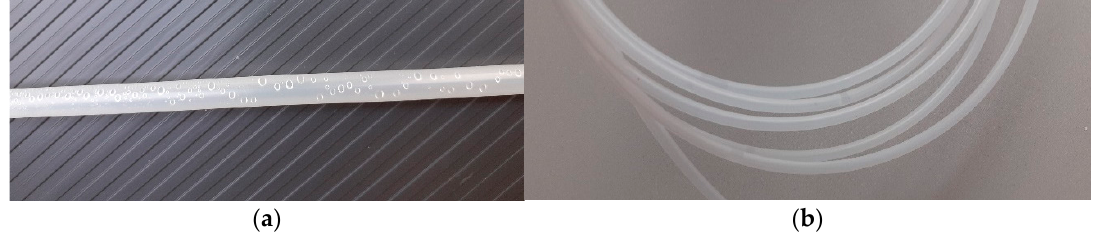
Figure 11. Condensate, which was formed inside gas line, during beehive air measurements: ( a ) initially condensate adheres to the walls of the tubing, ( b ) later, the amount of condensate may be sufficient to block the tubing.